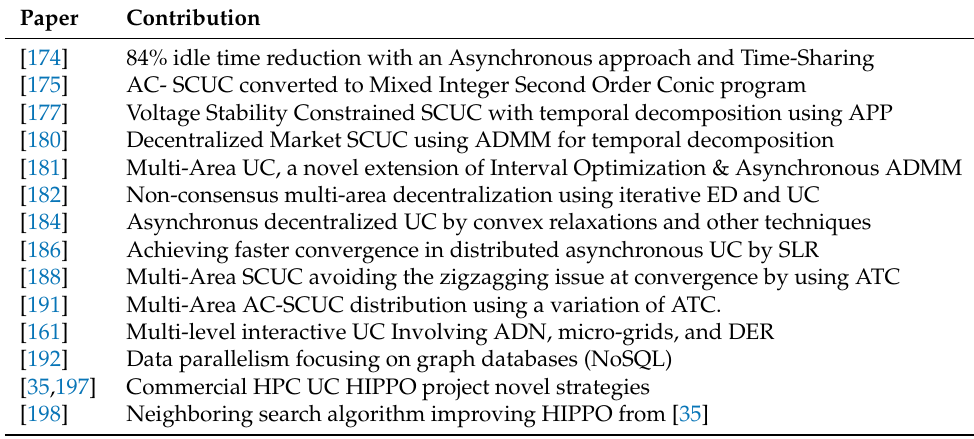
Figure 9. HIPPO Concurrent Optimizer (vertically aligned processes run in parallel). Table 5. Unit Commitment MIMD based state-of-the-art